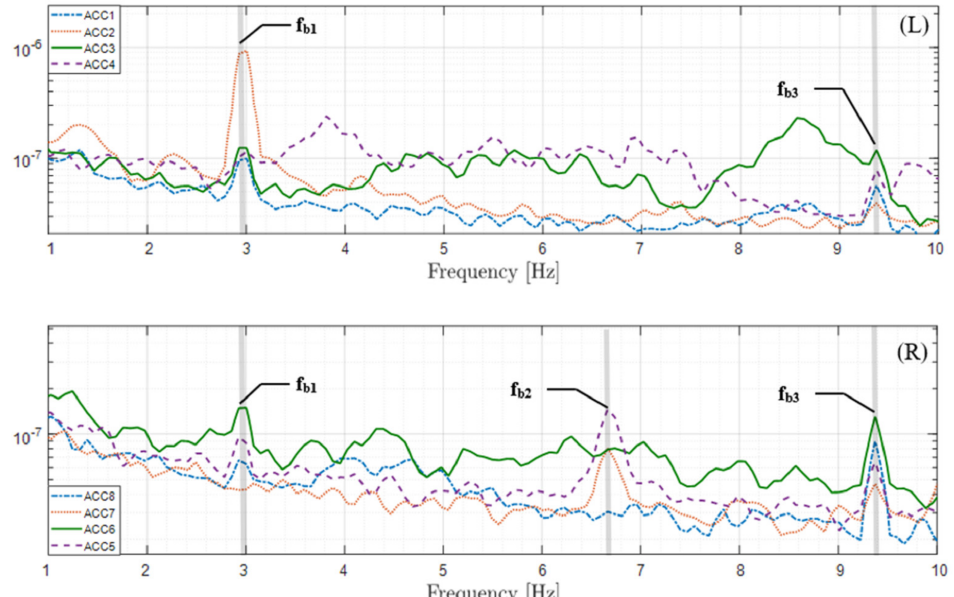
Figure 6. PSDs obtained from the acquisitions made with the accelerometers in the structure in Case 3; data from accelerometers positioned on the left-hand sidewalk (L) and the right-hand sidewalk